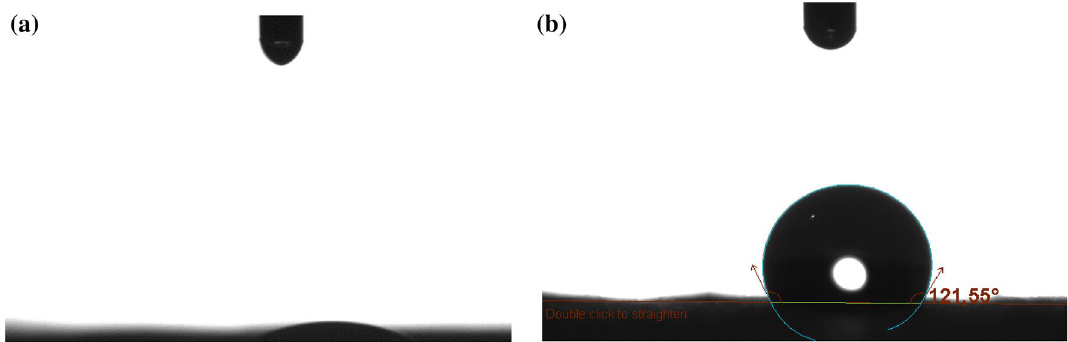
Figure 12. Contact angles obtained for ( a ) neat PAN and ( b ) composite PAN nanofibers with 50% PCMs